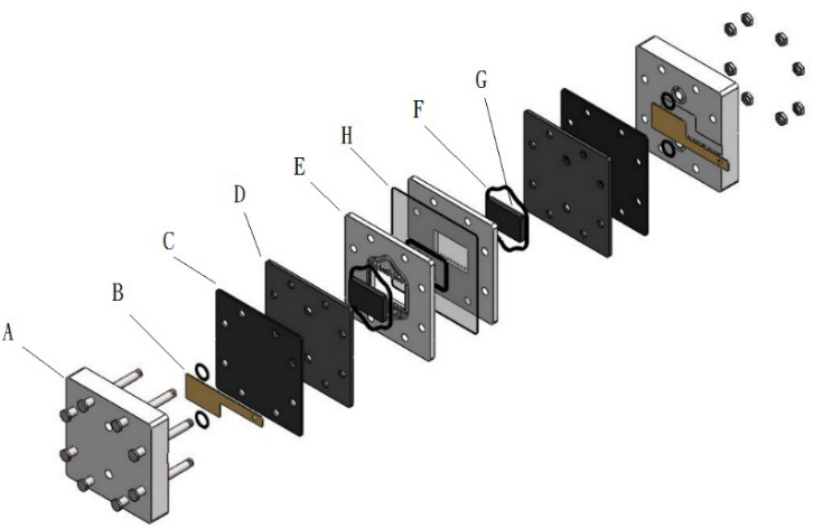
Figure 2. Exploded view of the VRFB. A: end plate; B: current collector; C: flexible graphite foil; D: